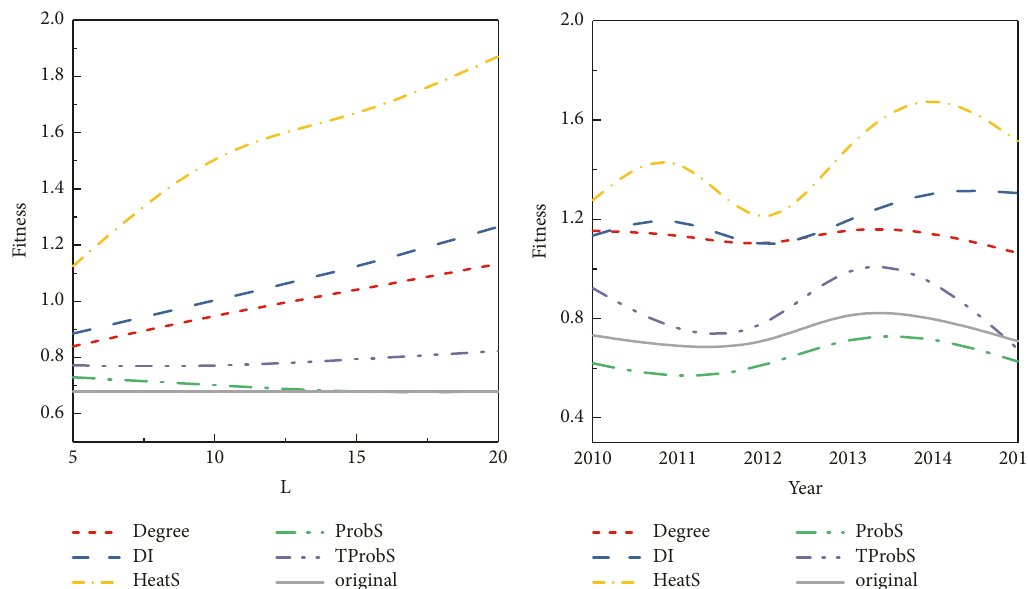
Figure 3: Panel (a) shows fitness values as a function of the length of the recommendation list 𝐿 . The results are average over 30 randomly selected countries and over the 15 years spanned by the data. Time evolution of fitness for the thirty selected middle tier countries that are shown in panel (b). The length of the recommendation list is set to 𝐿 = 20